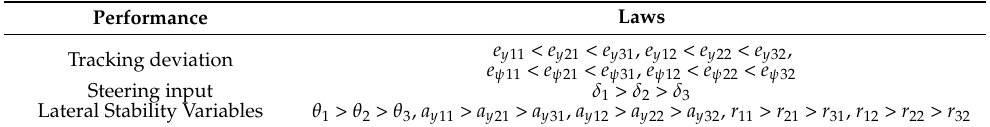
Table 3. Laws presented by the simulation results at bend 2.